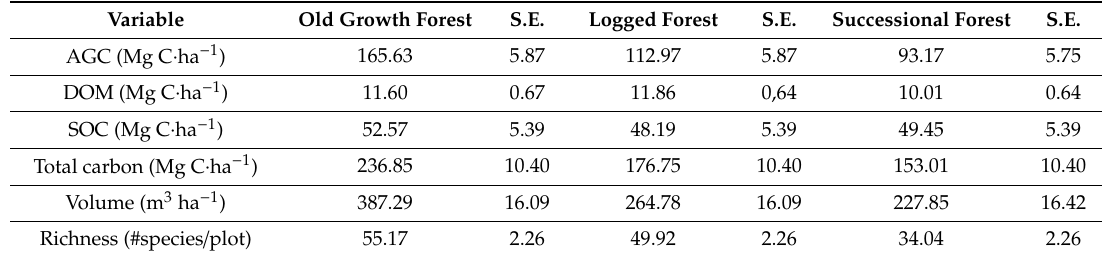
Table A6. Mean values and standard error of AGC, DOM, SOC, total carbon, timber volume and species richness for forest